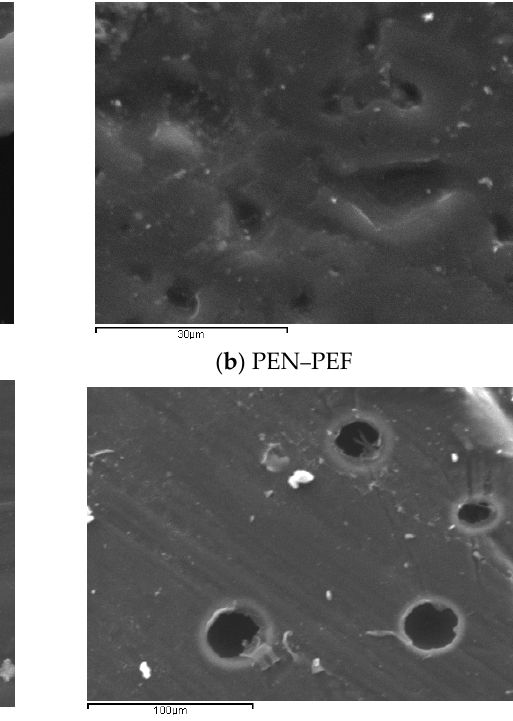
Figure 6. PLM photographs showing the melt phase of 50-50 blends: ( a ) PC–PEF, ( b ) PEN-–PEF, ( c ) PET–PEF, ( d ) PCHDMF-–PEF, ( e ) PLA–PEF, ( f ) PPF–PEF, ( g ) PBF–PEF, ( h ) PBF–PPF, ( i ) PPT–PPF, ( j ) PCHDMF–PPF.